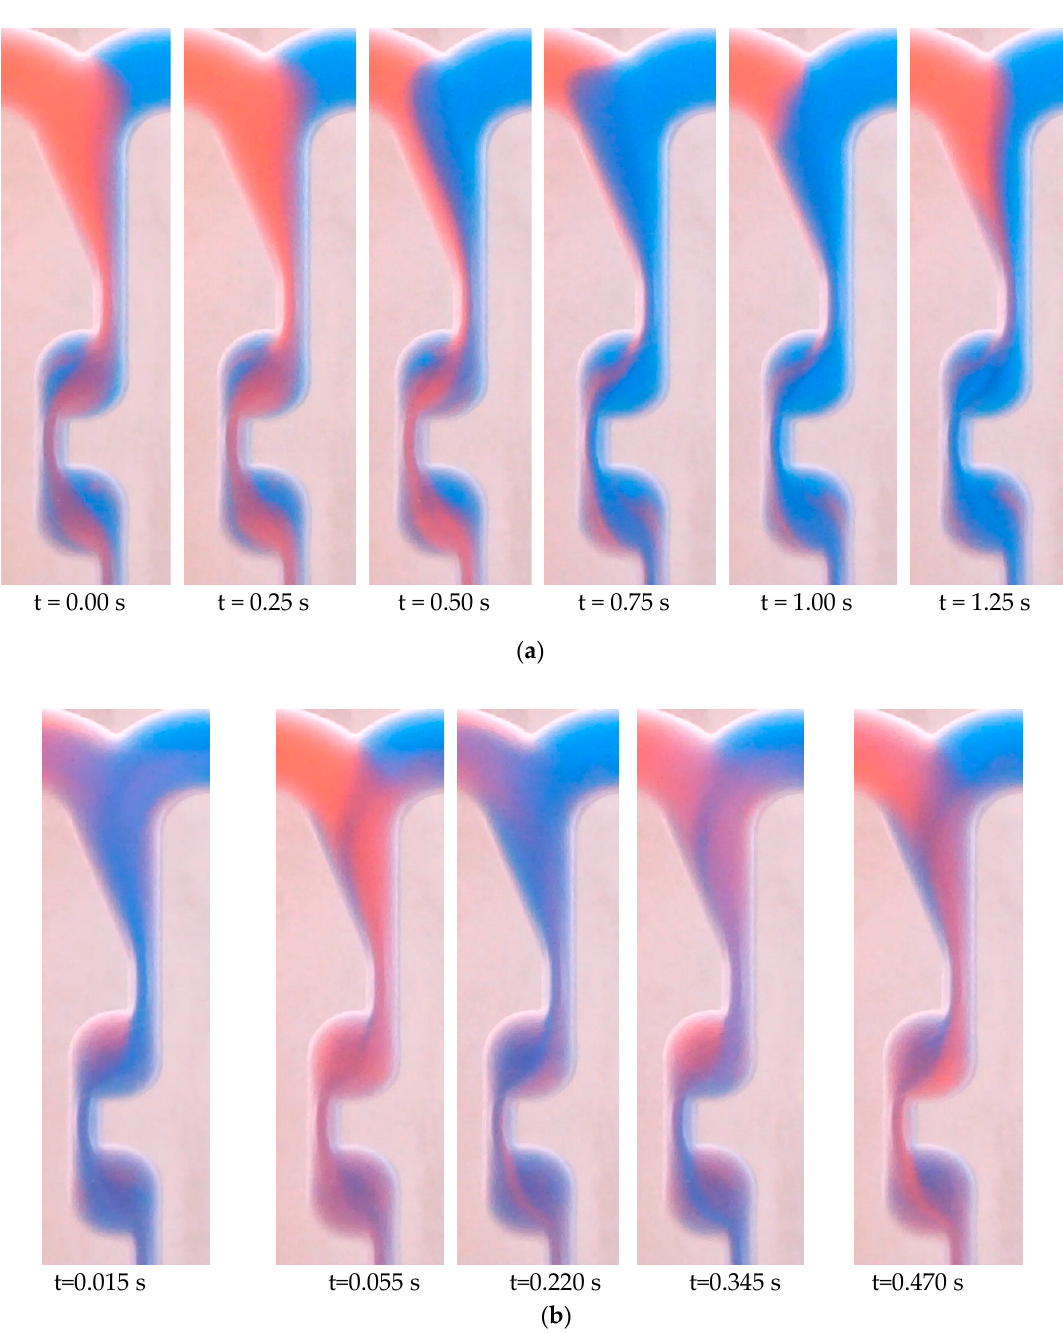
Figure 5. Different mixing states of two solutions in chicane microreactor using piston pumps: ( a ) volume flow rate of 1 mL/min; ( b ) volume flow rate of 6 mL/min.